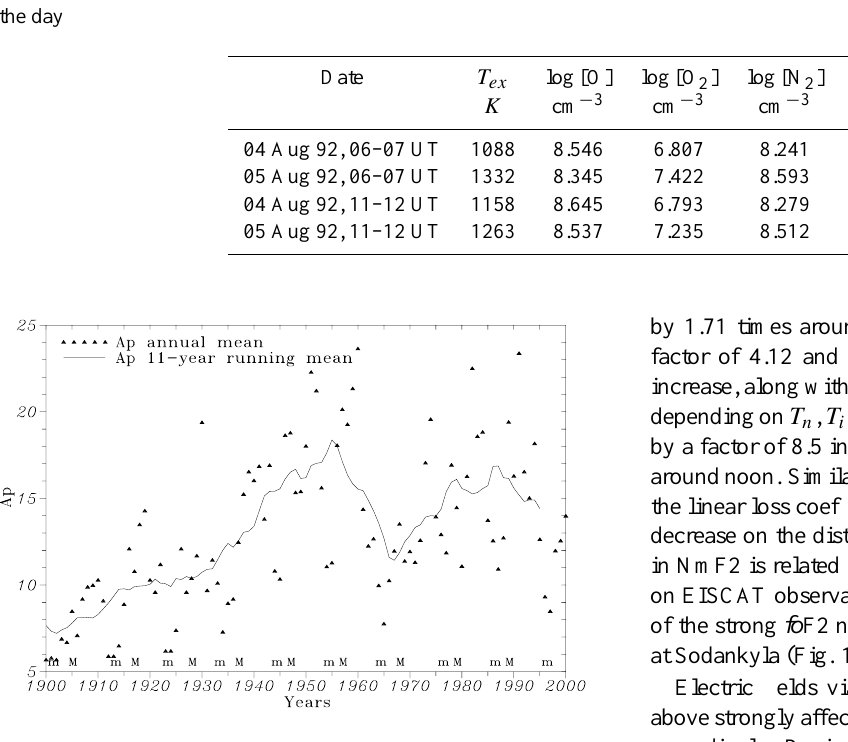
Fig. 8. Annual mean and 11-year running mean Ap index variations. Symbols (m) and (M) refer to years of solar cycle minimum and